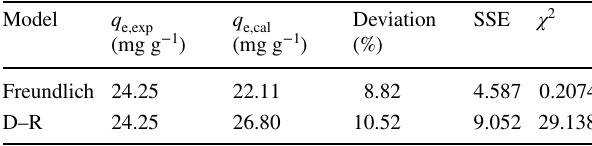
Table 5 Isotherm model validity evaluation (308 K)